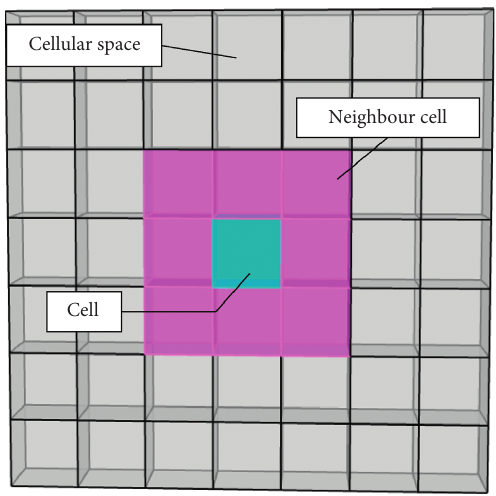
Figure 1: Schematic diagram of the basic structure of